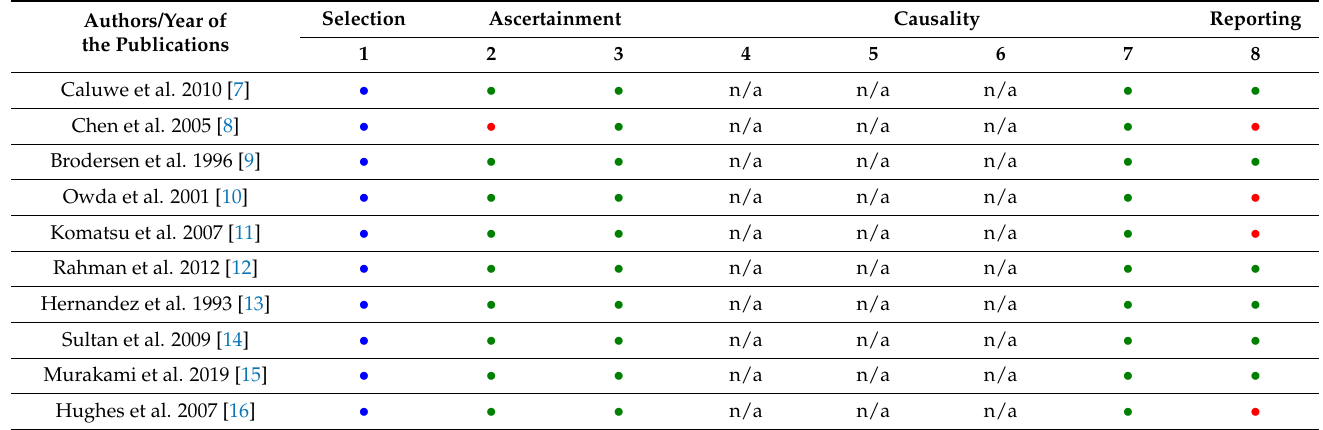
Table 1. Quality assessment of included case reports and case